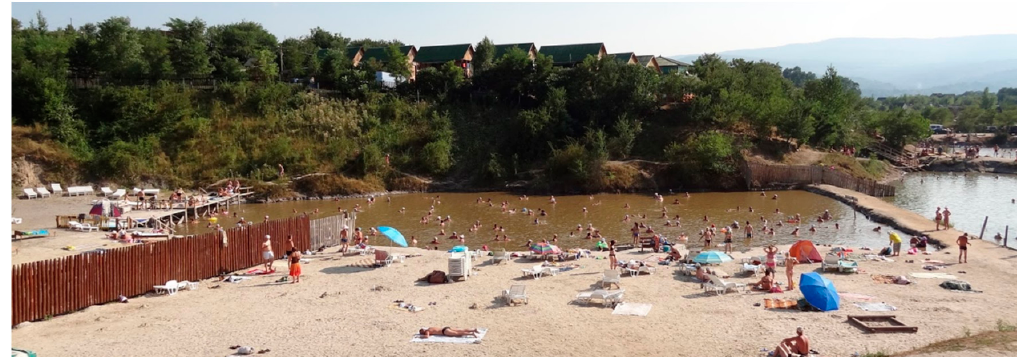
Figure 2. The images of Solotvyno. The first image is the map of Solotvyno. The second image is a schematic geological–structural section (natural base for groundwater movement and karst cones subsidence development). From the schematic geological–structural section, Mine 7, 8, and 9, are represented. The zones of weakness are indicated, where the removal of the protective clay layer during salt exploitation led to the filtration of freshwater into the salt dome and flooding of the salt mines. We derived the second image from the Institute of Geological Sciences—National Academy of Sciences of Ukraine (IGS NASU). The third image is an illustration of one of the salt lakes, created when the salt mines subsided and collapsed. The last picture is a portion of the recreation center in Solotvino—solná jezera; it is crowded with approximately 3000 tourists in the summer season, every year [58,59]. The tourists come to Solotvyno for recreation and healing from the salt lakes. The salt lakes developed when the mines were flooded.